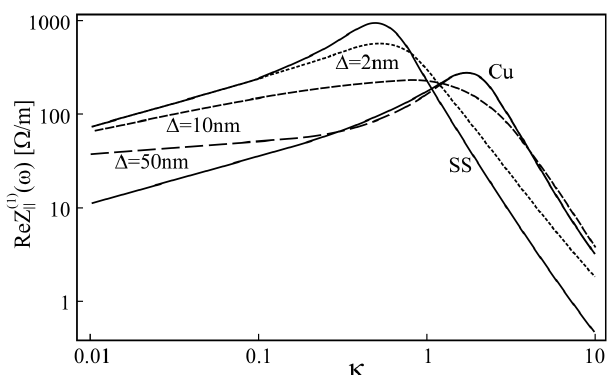
FIG. 3. The real part of stainless steel–copper tube longitudi- nal dipole impedance for various thickness of the inner copper layer. Tube inner radius is 2 mm. The smooth curves present the ordinary copper (Cu) and stainless steel (SS) single-layer tube